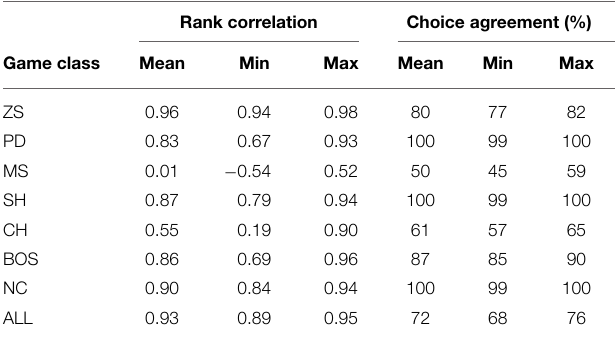
TABLE 2 | Agent heterogeneity—rank correlation of choice probabilities and % choice agreement. Rank correlation Choice agreement